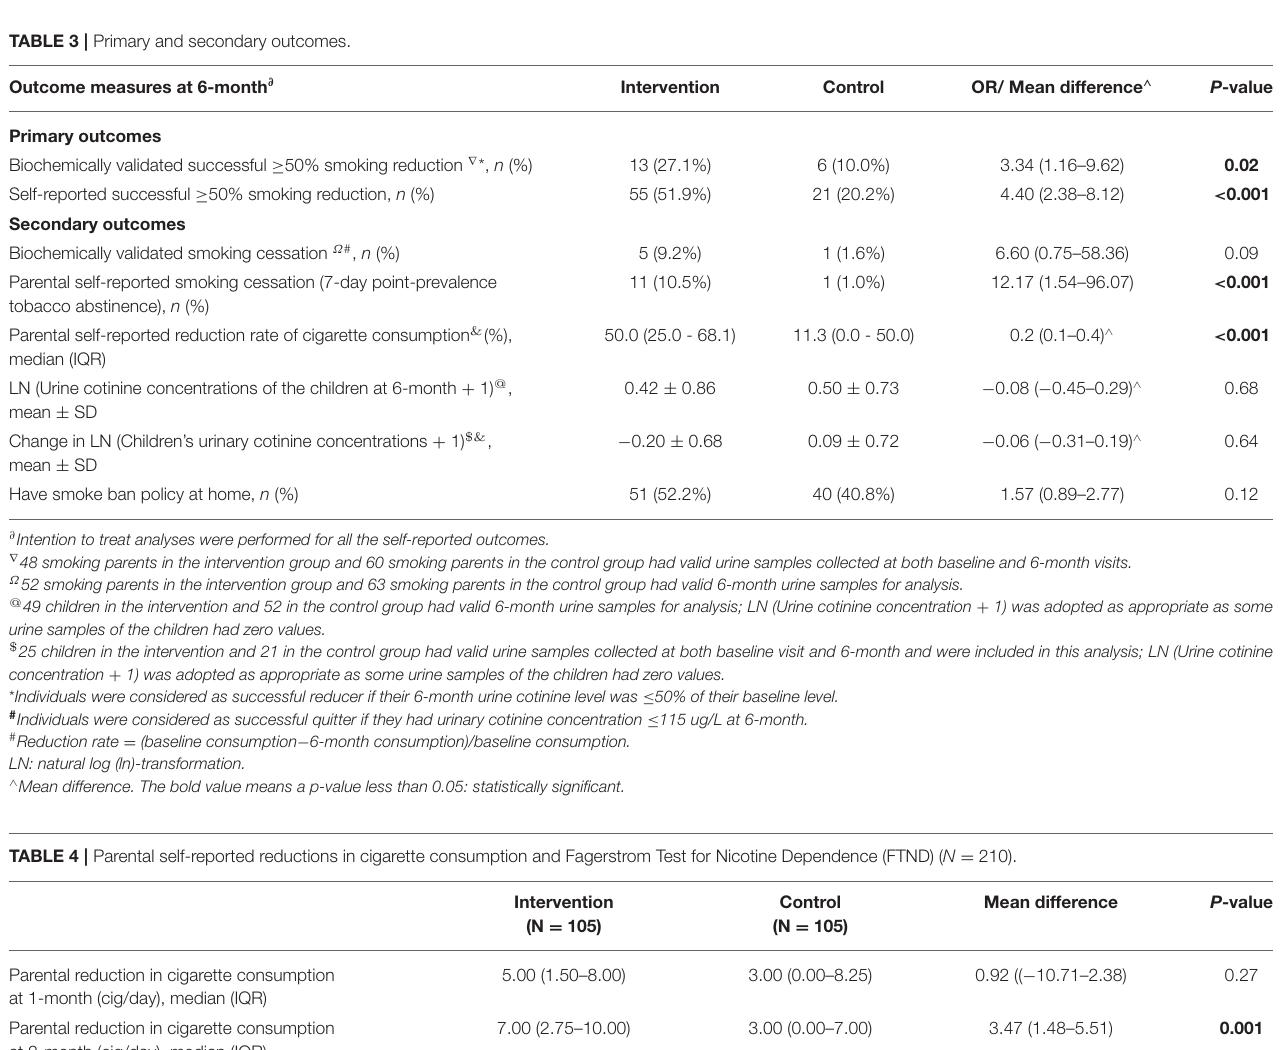
Secondary outcomes